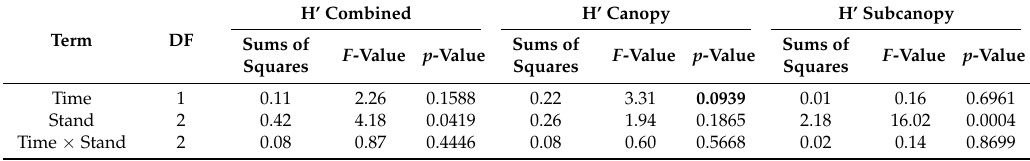
Table A3. Full factorial two-way ANOVA testing for differences between stands, and the effect that time (before and after disturbance) or time × stand had on Shannon’s Diversity Index (H’) for the subcanopy, canopy, and combined (subcanopy and canopy) strata. Significant differences are in